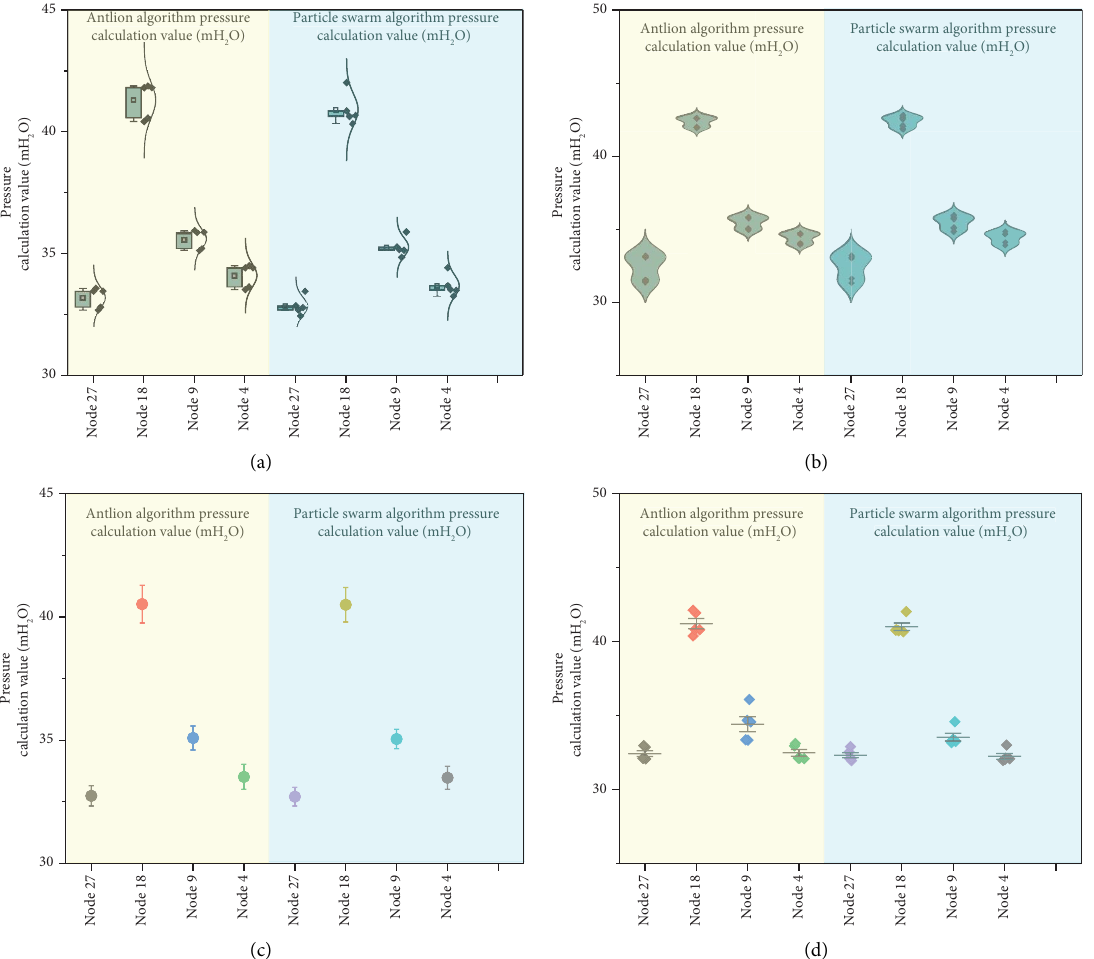
Figure 5: Te pressure calculation value of the pressure measuring point under the optimal ftness. (a) Node 27. (b) Node 18. (c) Node 9. (d) Node